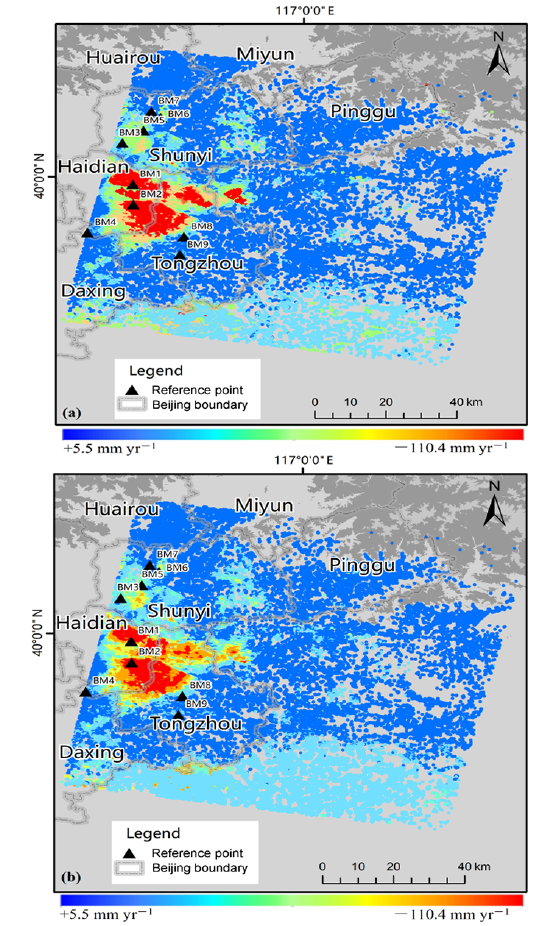
Figure 5. Comparison of deformation velocity calculated for Bei- jing between 2014 and 2016 for two cases, using (a) PSI and (b) FFT + PSI (The Digital Elevation Model (DEM) with a spatial resolution of 90m was used as a basemap. DEM ©Geospatial Data Cloud 2016).